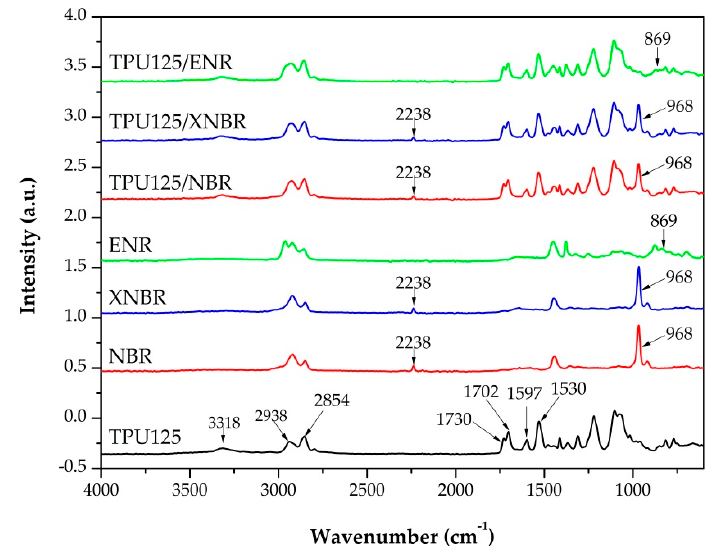
Figure 11. Fourier-transform infrared spectra of the TDVs and TPU125.